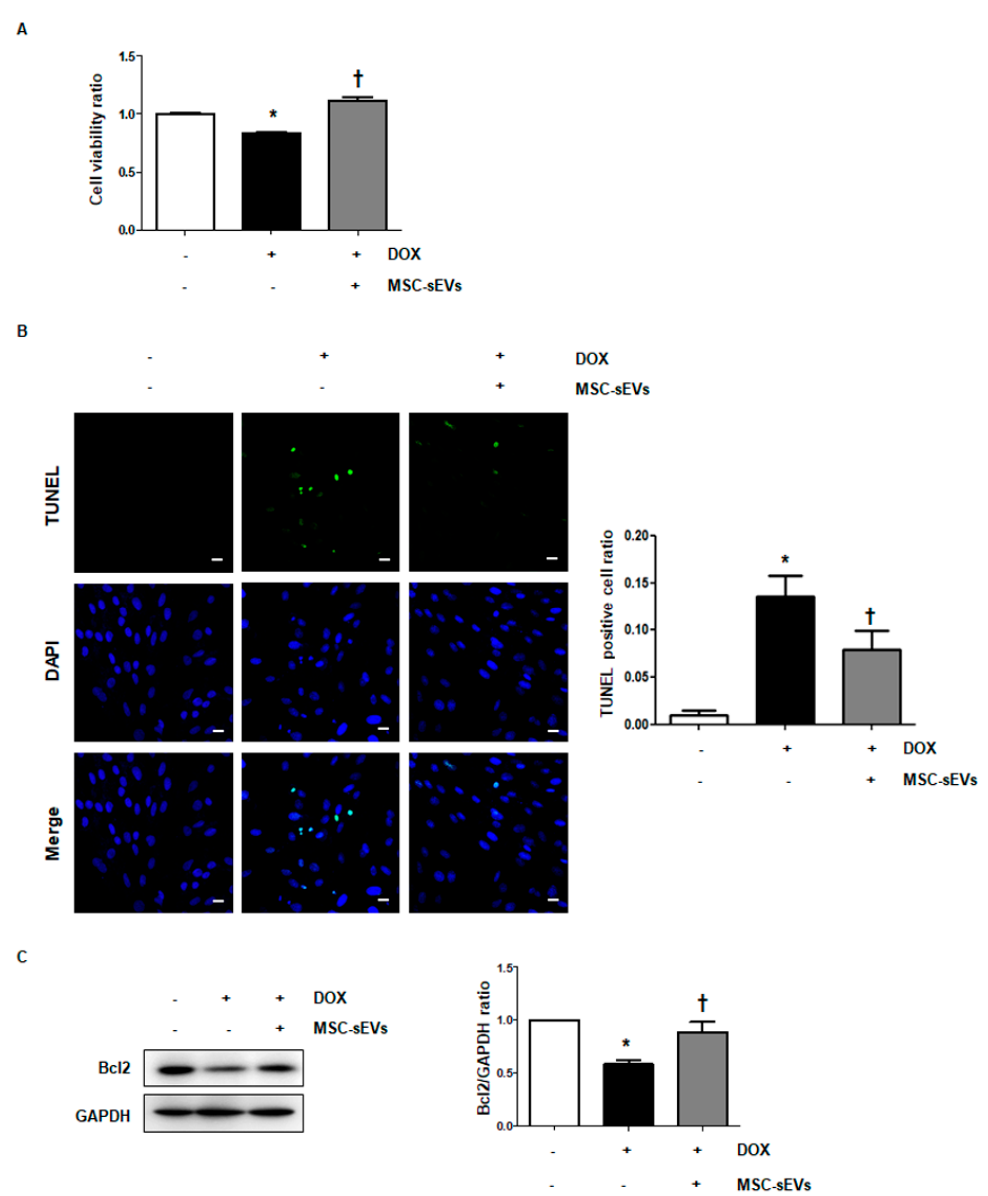
Figure 1. MSC-sEVs protect cardiomyocytes from DOX − induced cell death. H9c2 cells were pretreated with MSC-sEVs (3 × 10 9 ) for 24 h prior to DOX (1 μ M) for 24 h. ( A ) Cell viability was measured using the MTT assay ( n = 5). * Significant difference compared to the control ( p < 0.05). † Significant difference compared to the DOX treatment ( p < 0.05). ( B ) The bar graph shows the TUNEL − positive cell ratio as a cellular apoptotic index. TUNEL − stained cells (green) were counted and normalized to DAPI − stained cells (blue): control (0.0097 ± 0.0048, mean ± SEM), DOX (0.1361 ± 0.0220, mean ± SEM) and MSC-sEVs +DOX (0.0784 ± 0.0207, mean ± SEM) ( n = 5). * Significant difference compared to the control ( p < 0.05). † Significant difference compared to DOX treatment ( p < 0.05). Representative fluorescence microscopic TUNEL images from at least three independent experiments are shown (magnification, 200 × ; scale bars, 10 µ m). ( C ) Protein levels of Bcl − 2 were measured by Western blotting ( n = 5). * Significant difference compared to the control ( p < 0.05). † Significant difference compared to DOX treatment ( p <